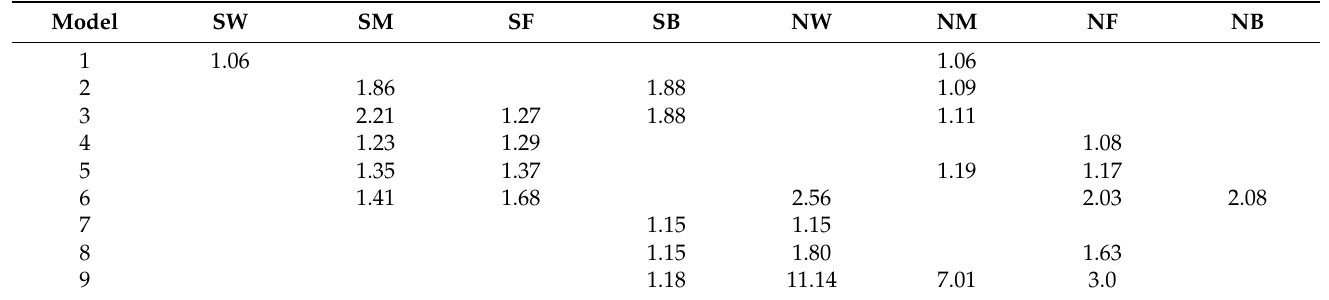
Table 3. Evaluation of multicollinearity of proposed models using Variance Inflation Factor